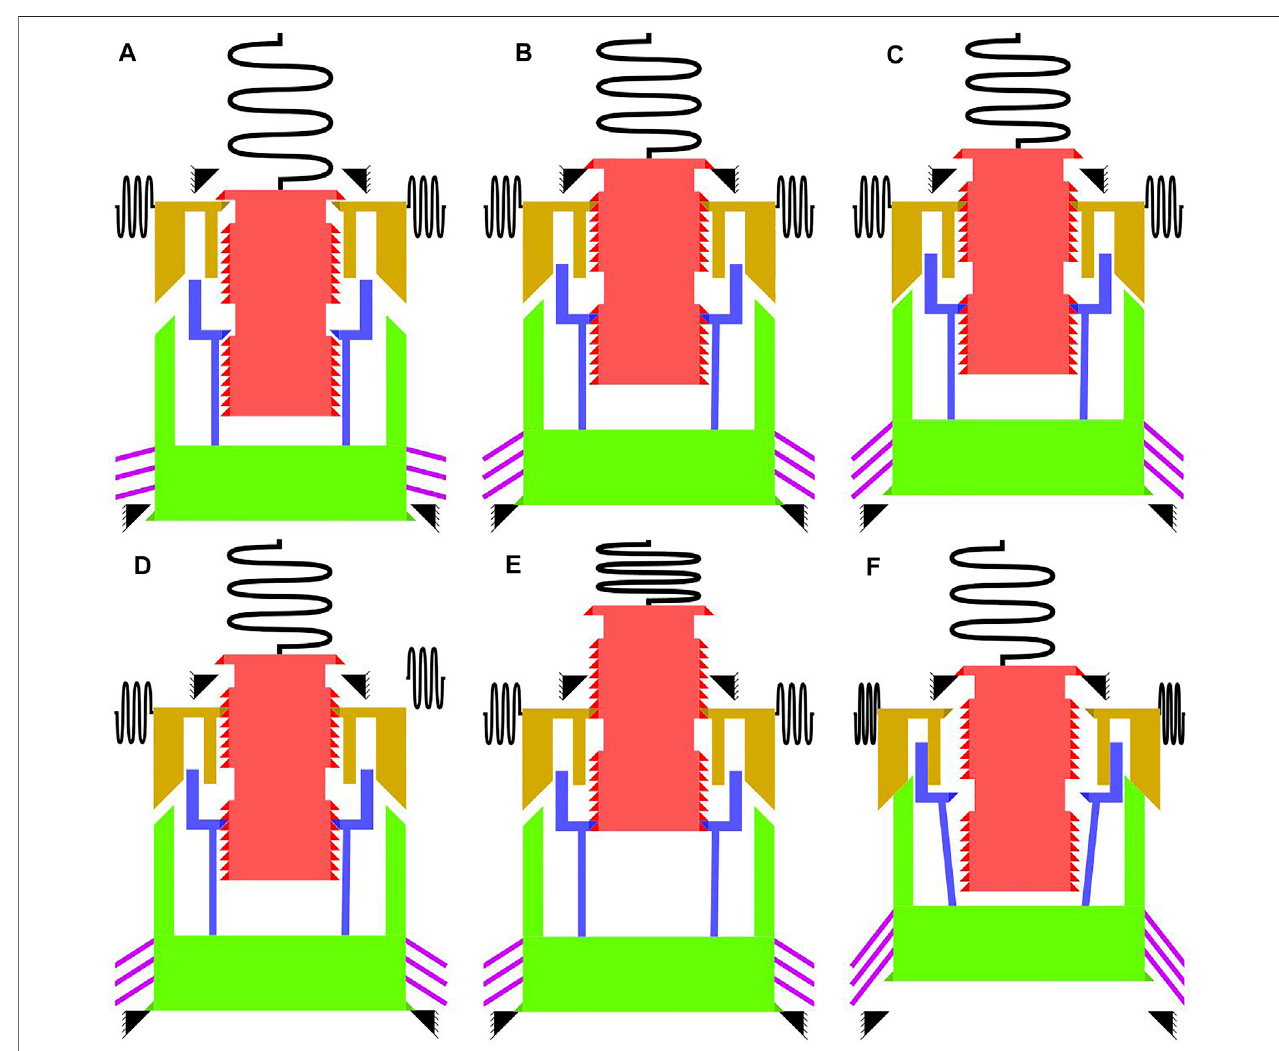
FIGURE 1 | Working principle for the multistable microsystem, consisting of a mobile part (red), actuator (purple), actuator shuttle (green), top gripper (yellow), bottom gripper (blue), and springs connected to the grippers and mobile part: (A) as-fabricated con fi guration; (B) armed con fi gurations at the initial position; (C) con fi guration when the actuator is activated at a low level to move the mobile part one step up; (D) con fi guration at the second stable position when the actuator is deactivated; (E) con fi guration after several upward steps are implemented until the last stable position; (F) con fi guration when the actuator is activated at a high level to open both grippers, and the mobile part returns to the initial